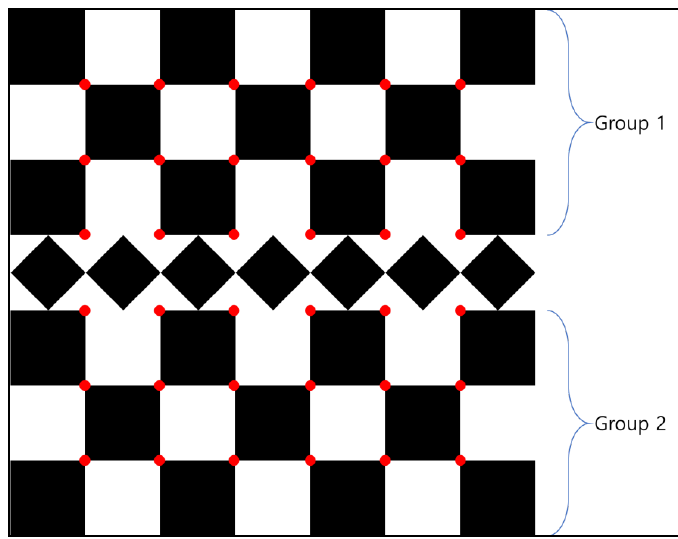
Figure 8. Division of areas where squares exist.